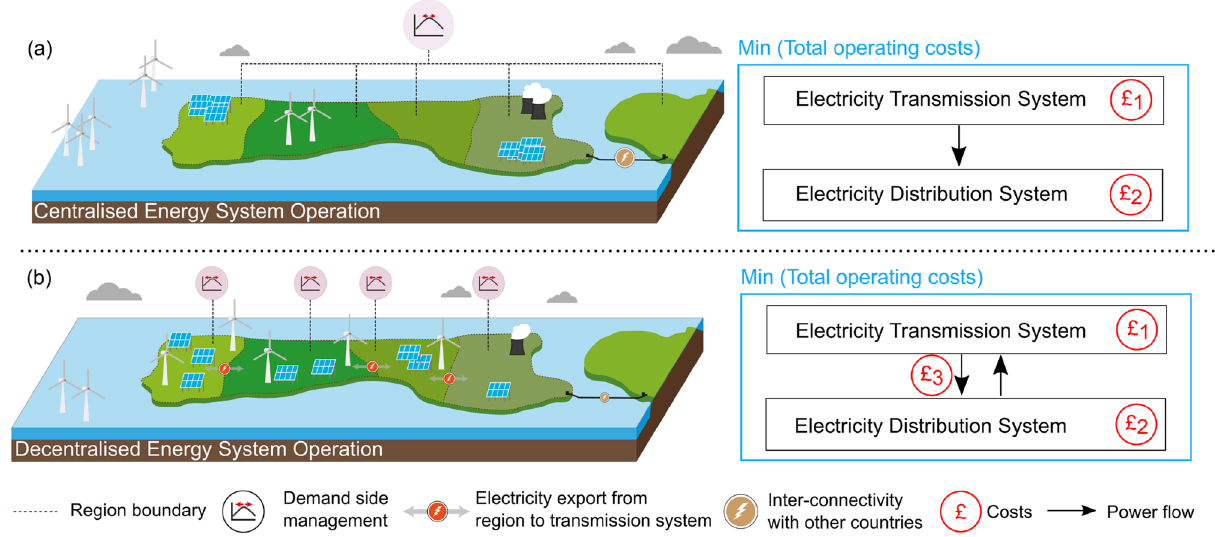
Figure 2. Stylised representation of ( a ) centralised and ( b ) decentralised energy system operation and illustration of differences in the cost optimisation modelling approach. The level of prominence given